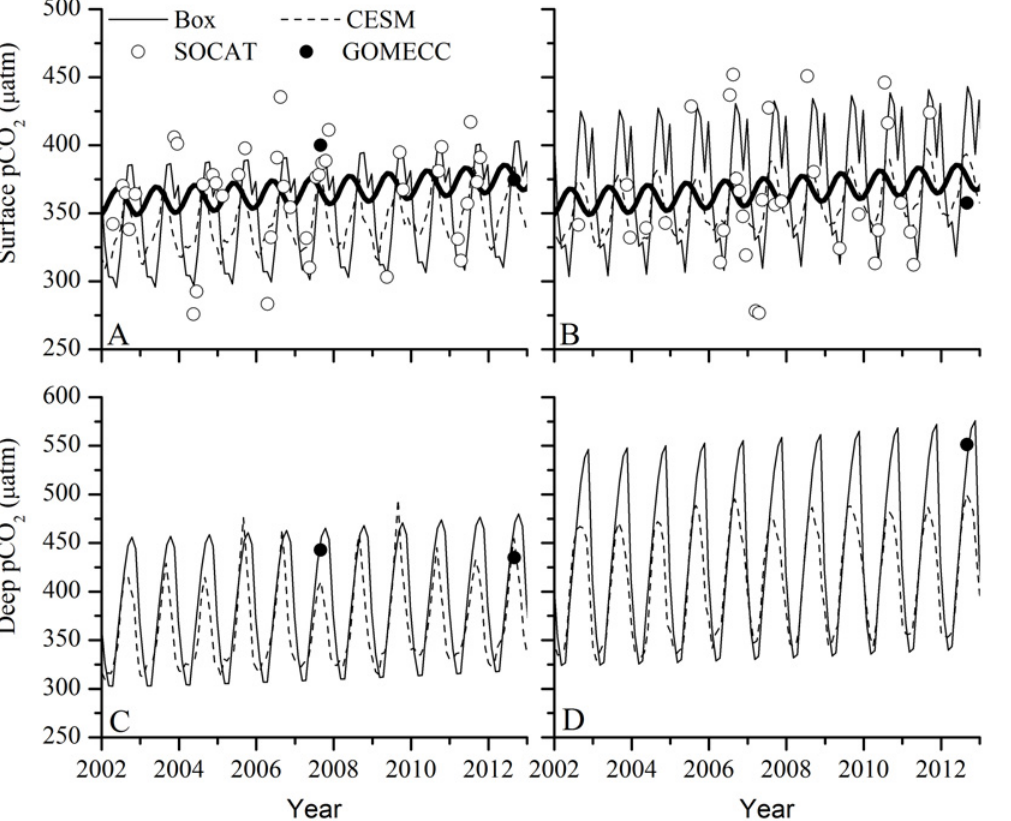
Fig 9. (A) Georges Bank and (B) Mid-Atlantic surface pCO 2 from the box model (solid), the global CESM model (dashed), and atmospheric CO 2 forcing (heavy solid). Open circles are from the SOCAT gridded database [68] and closed circles are from the GOMECC I [24] and II (Wanninkhof pers. comm) cruises in 2007 and 2012. (C) Georges Bank and (D) Mid-Atlantic deep pCO 2 from the box model (solid) and the global CESM model